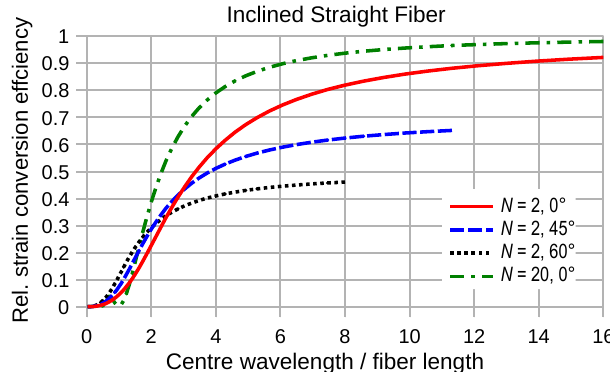
Figure 13. Conversion efficiency of a straight fiber segment oriented parallel or inclined to the wave propagation direction as a function of λ M / D .